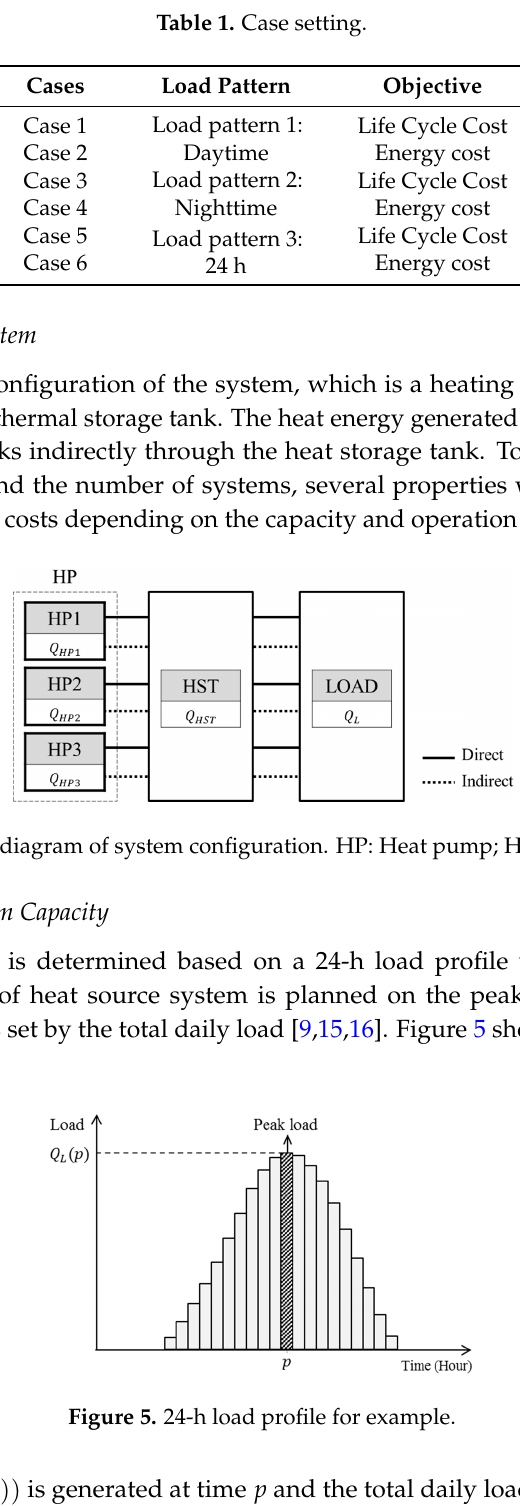
Figure 5. 24 ‐ h load profile for example. Figure 5. 24-h load profile for